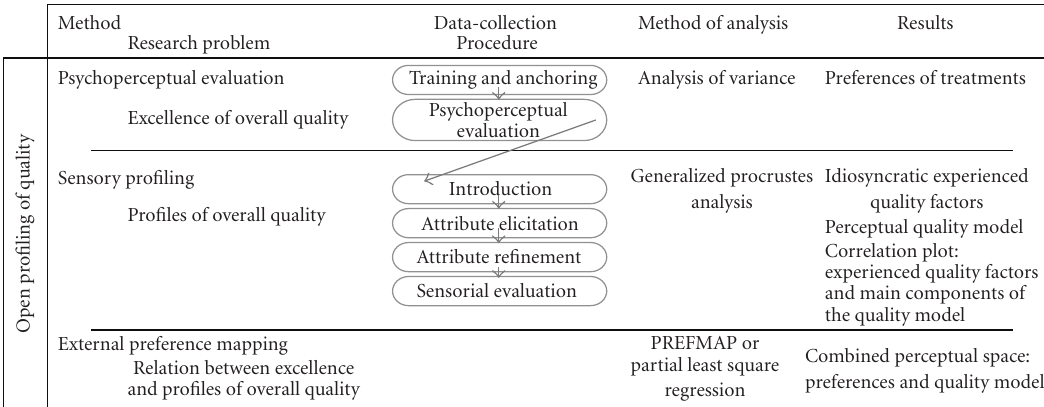
Figure 1: Overview of the subsequent steps in Open Profiling of Quality including respective research